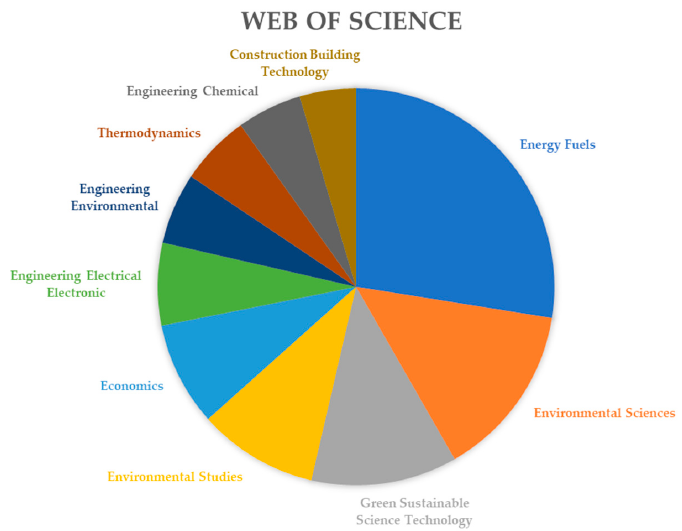
Figure 7. Top 10 subject areas in Web of Science based on articles published annually using first query. Source: Own elaboration.